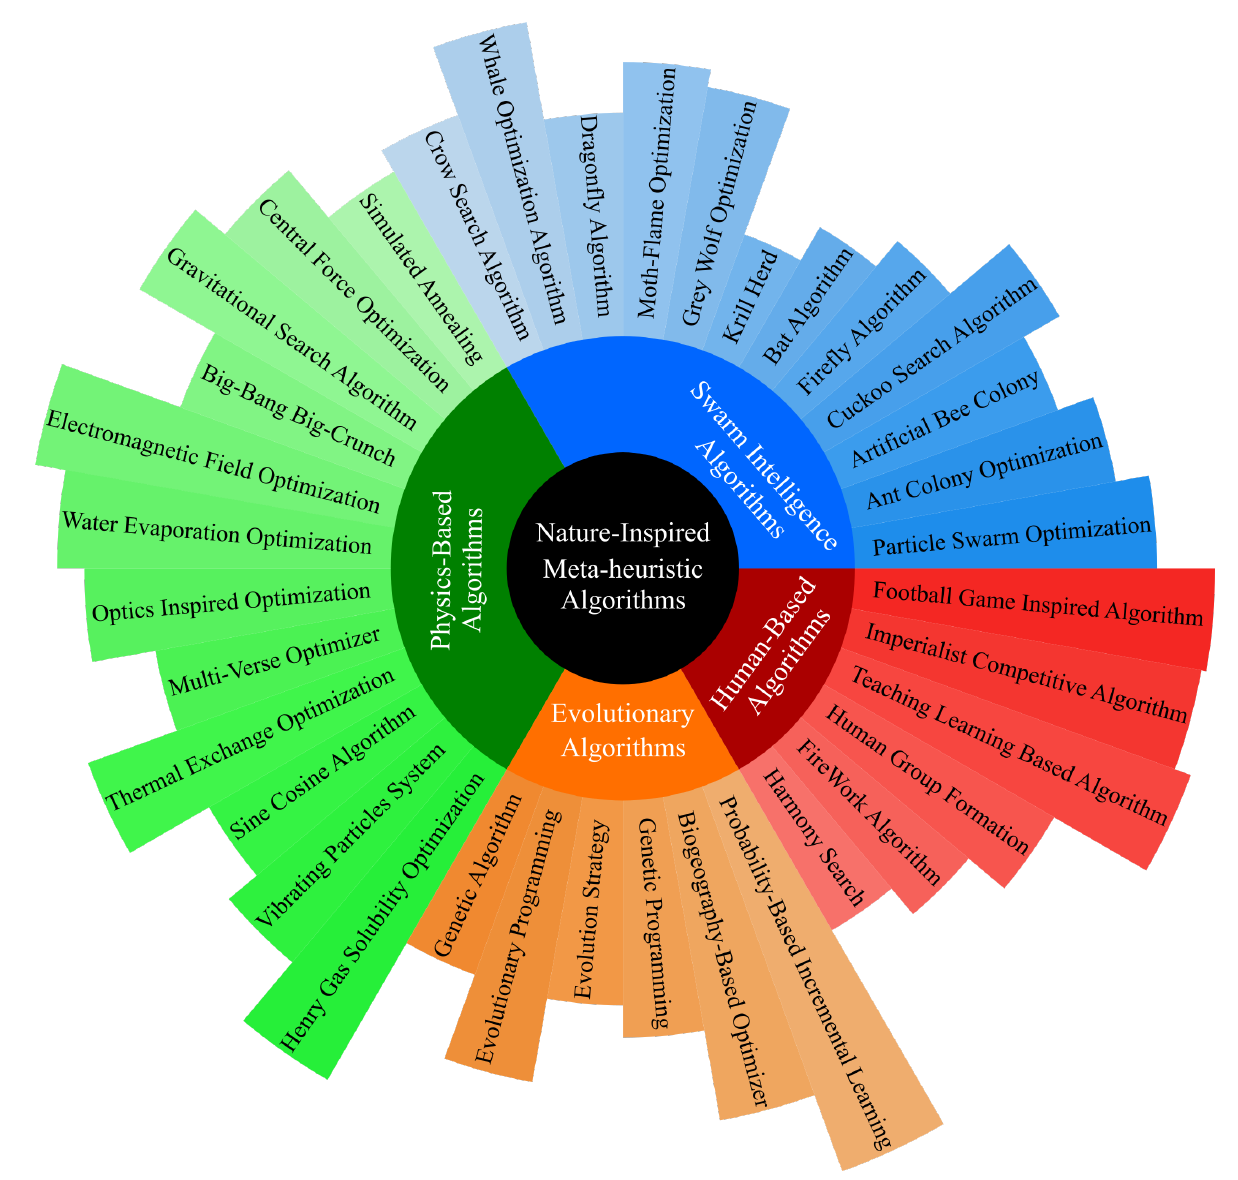
Figure 6. Nature-inspired meta-heuristic algorithms and the position of SI algorithms in